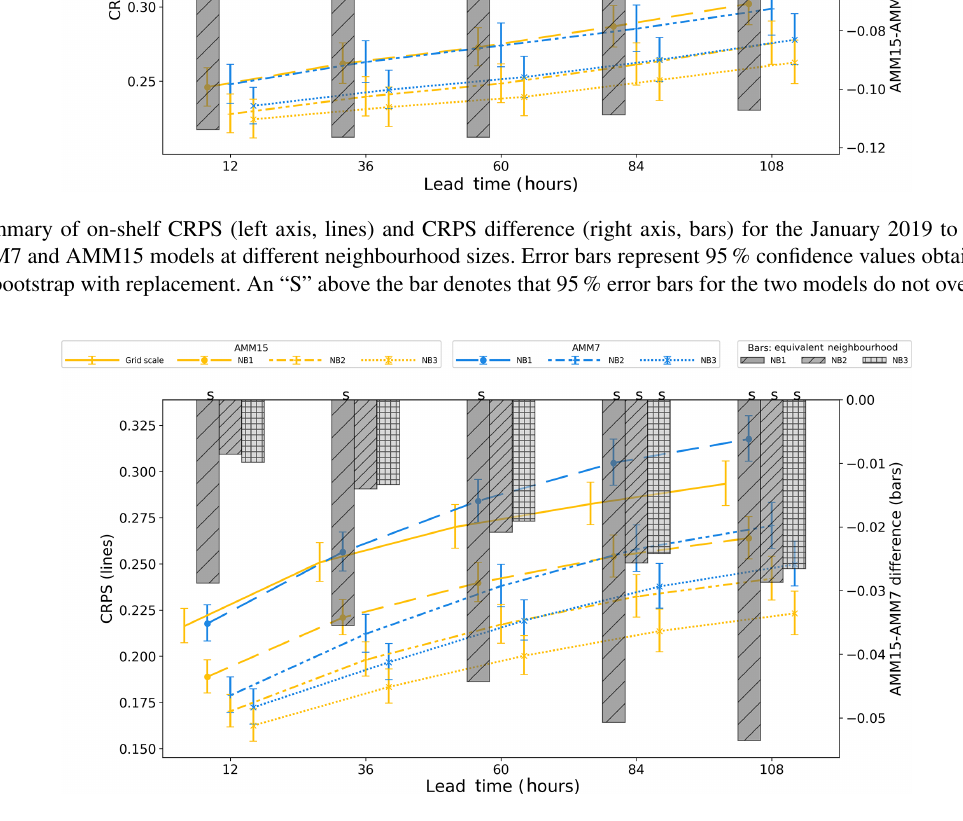
Figure 11. Summary of off-shelf CRPS (left axis, lines) and CRPS difference (right axis, bars) for the January 2019 to September 2019 period for AMM7 and AMM15 models at different neighbourhood sizes. Error bars represent 95% confidence values obtained from 10000 samples using bootstrap with replacement. An “S” above the bar denotes that 95% error bars for the two models do not